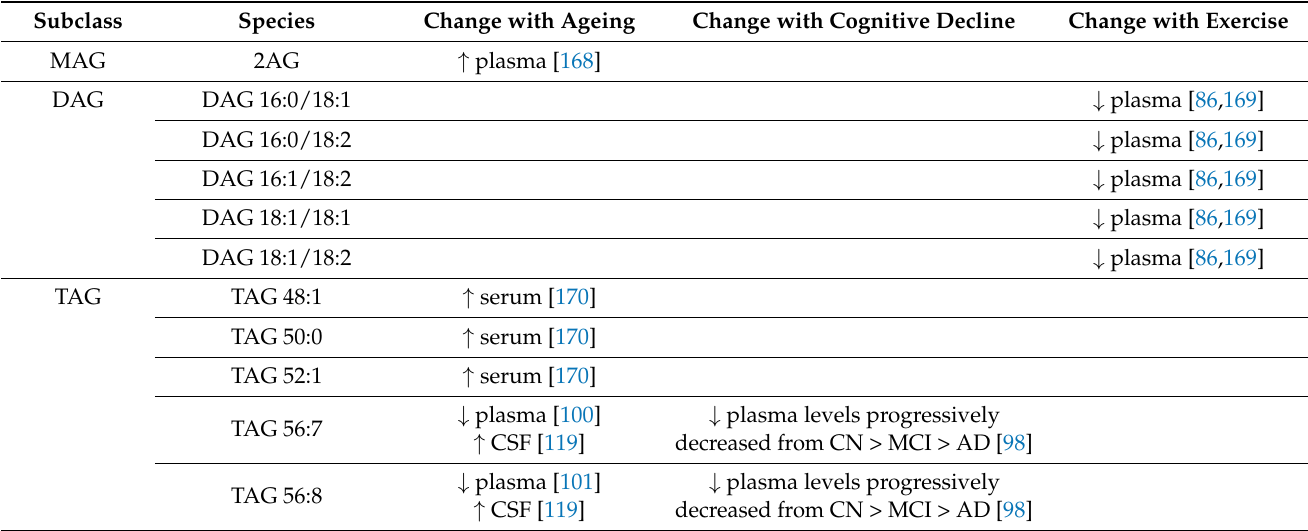
Table 2. Changes in glycerolipids with ageing, cognitive decline and exercise in